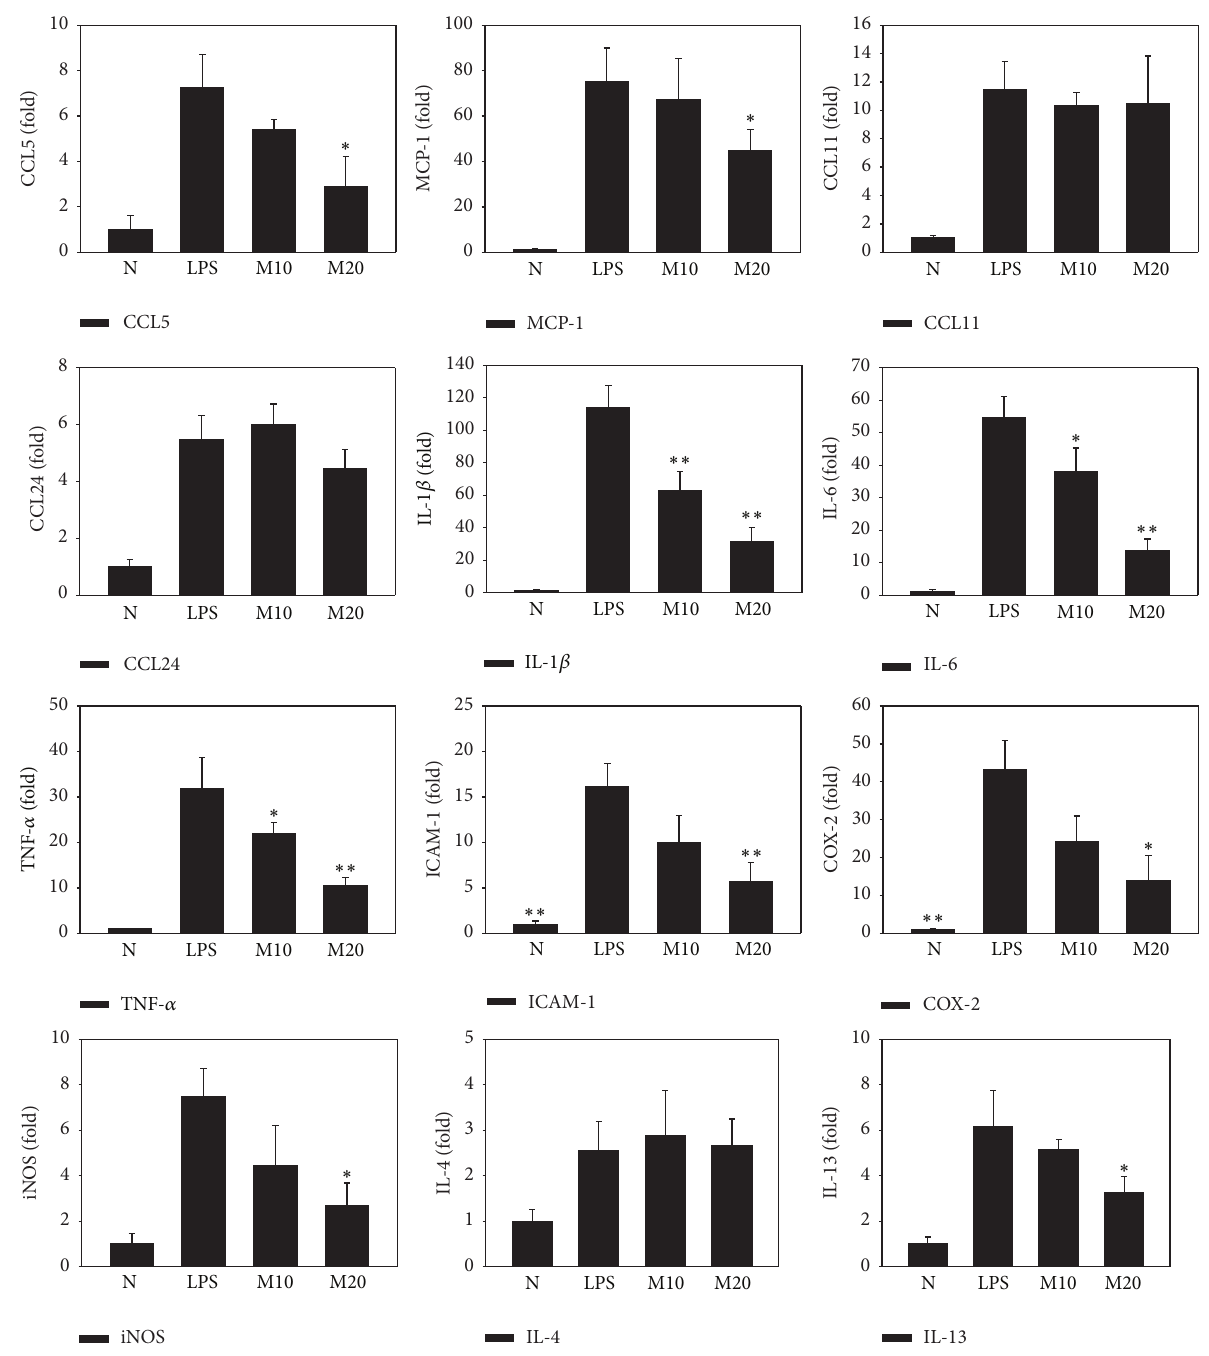
Figure 7: Matrine affects the expressions of cytokines, chemokines, and inflammatory mediators in the lung. Gene expressions were determinedusingreal-timeRT-PCR.Foldexpressionlevelsweremeasuredrelativeto 𝛽 -actinexpression(internalcontrol).Dataarepresented as mean ± SEM. ∗ 𝑃 < 0.05 compared with LPS control mice. ∗∗ 𝑃 < 0.01 compared with LPS control